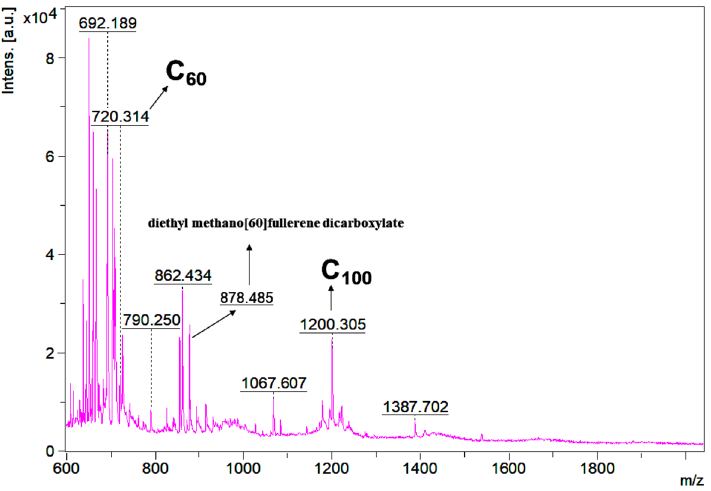
Figure 4. MALDI-MS spectra from a fine particle sample showing the fullerene diethyl methano[60]fullerene dicarboxylate observed as the ion with m/z